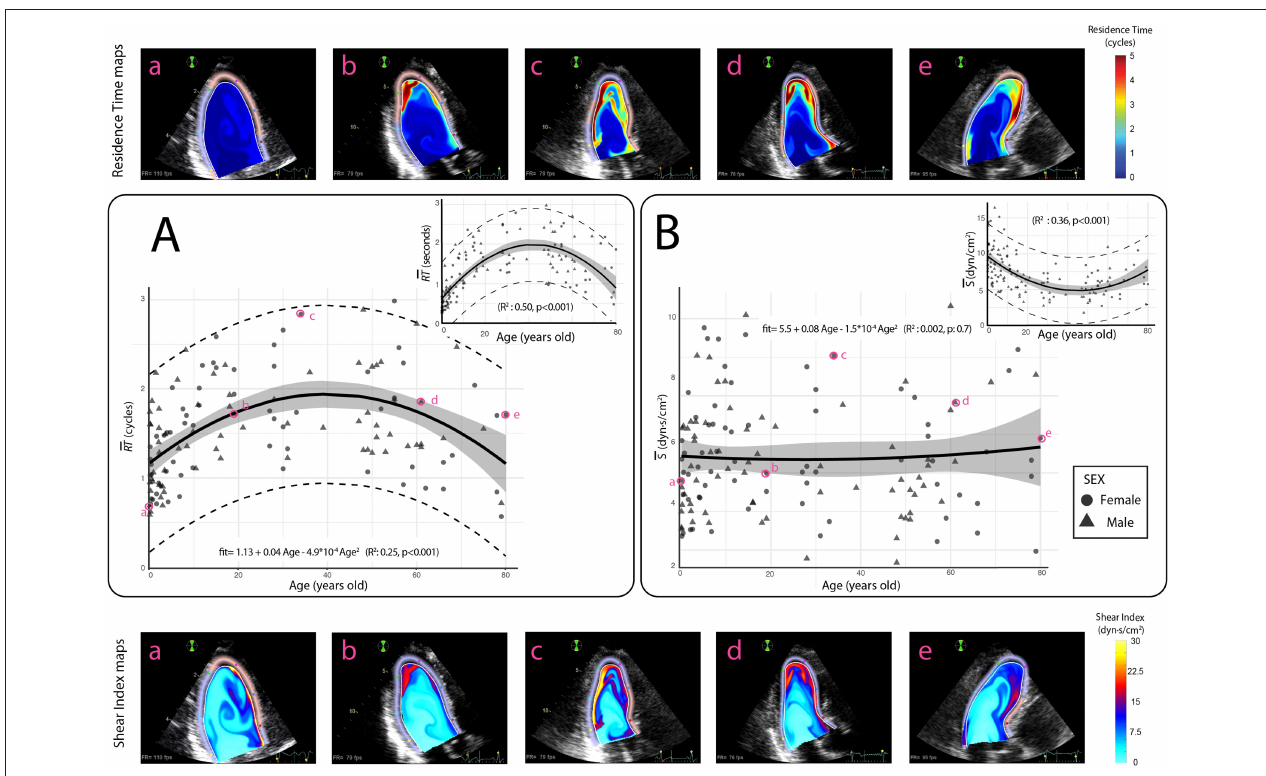
FIGURE 2 | Relationships between age and averaged residence time ( RT ) and shear index ( S ) of blood inside the LV. (A) Age variation of average RT (scaled in cycles). Insert: RT expressed in seconds. (B) Age dependence of S (scaled in dyn · s/cm 2 ). Insert: S expressed in dyn/cm 2 . Symbols account for sex. The solid black lines indicate the quadratic fits, the shadowed areas indicate the 95% confidence limits for the fittings and dashed lines indicate 95% prediction limits. Upper panels (a-e): RT maps and lower panels (a-e): S maps for selected patients (in magenta).